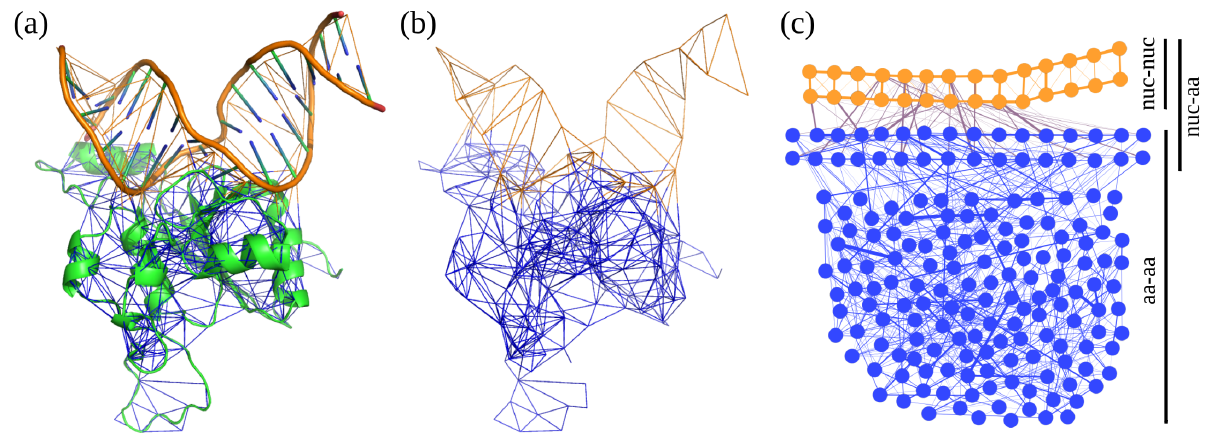
Figure 6. PRN models of the protein–DNA complex: ( a ) the PRN representation overlaid with the structure; ( b ) only the PRN without the structure; ( c ) a flat layout with the line thickness propor- tional to the interaction energy. Parts a-b are depicted with pyProGA [92], and part c is drawn with Gephi [95]. Orange and blue color denotes nucleotides (nuc) and amino acid (aa) residues,